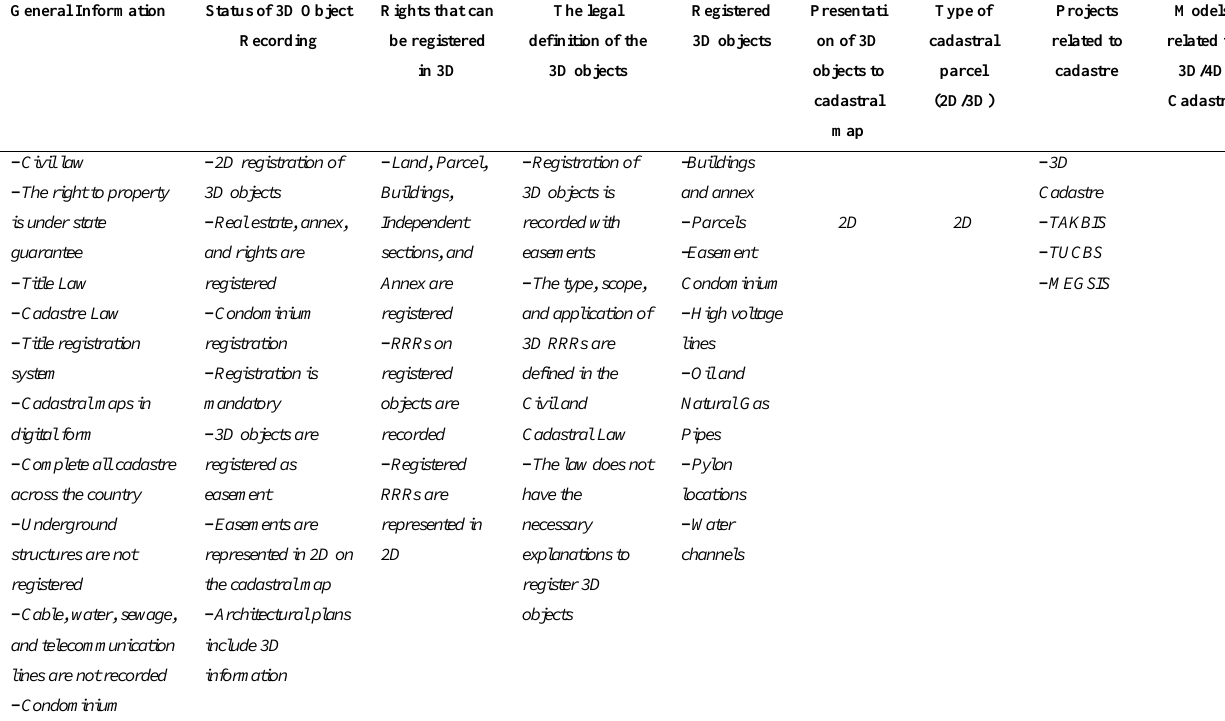
Table 1. Evaluation of Turkish cadastral system within the scope of 3D cadastre